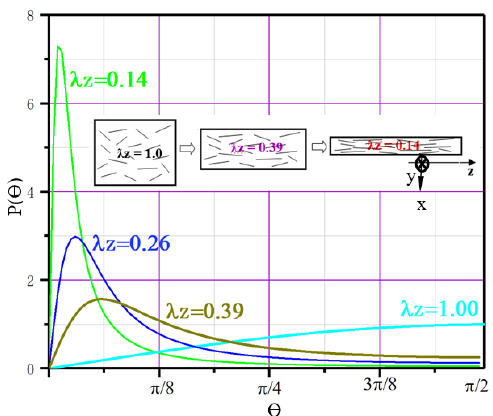
Figure 6. Modeled probability density of the orientation of in situ TiB fibers after thermal defor ‐ mation with different ratios of